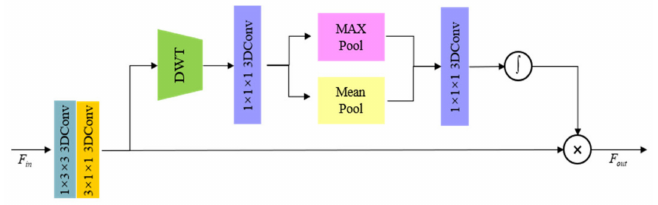
Figure 3. Architecture of the up/down block.